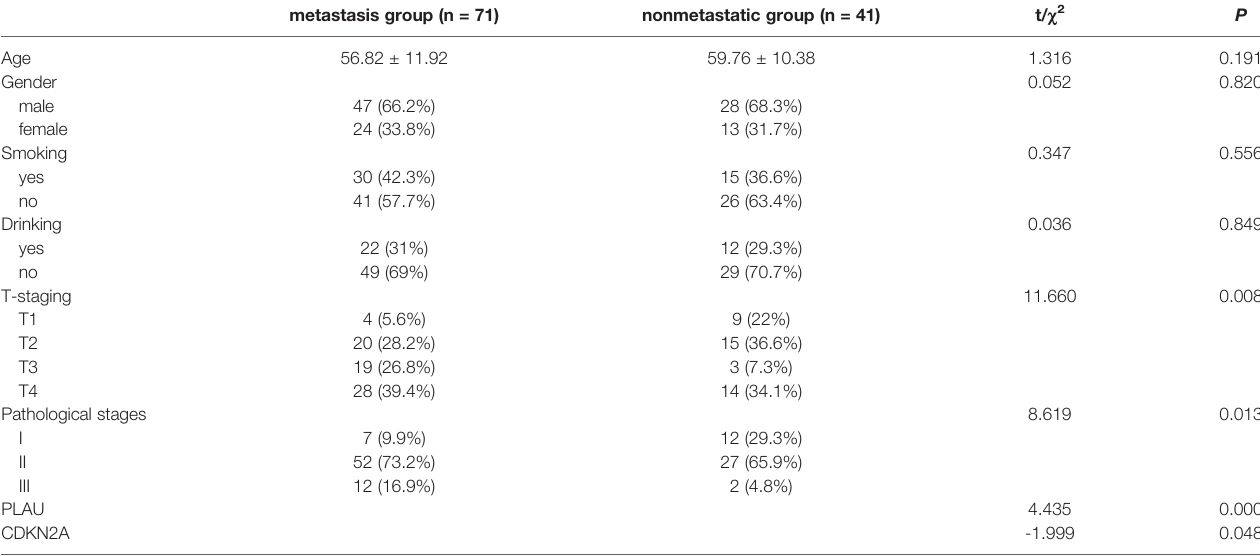
TABLE 1 | 112 OSCC clinicopathological parameters and gene expression analysis in retrospective data.